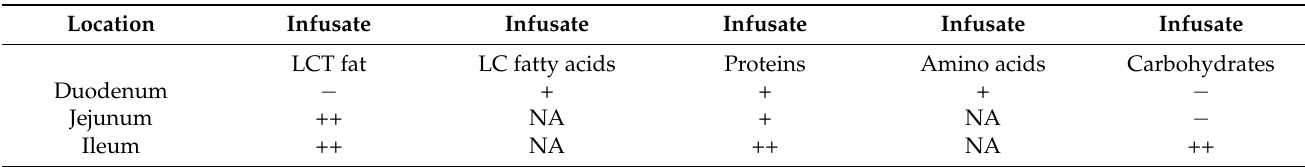
Combined results of data obtained from published studies listed in Tables 1–3 and individual data from Tables A1–A3. NA: not assessed. Net reduction: reduction in energy intake of meal minus energy content of infusate. − means net reduction in energy intake is negative: increase in the amount of calories ingested. = means no net reduction in energy intake, reduction in energy intake of meal = energy content of infusate. +/++/+++ means net reduction in energy intake: reduction in energy intake of meal > energy content of infusate +